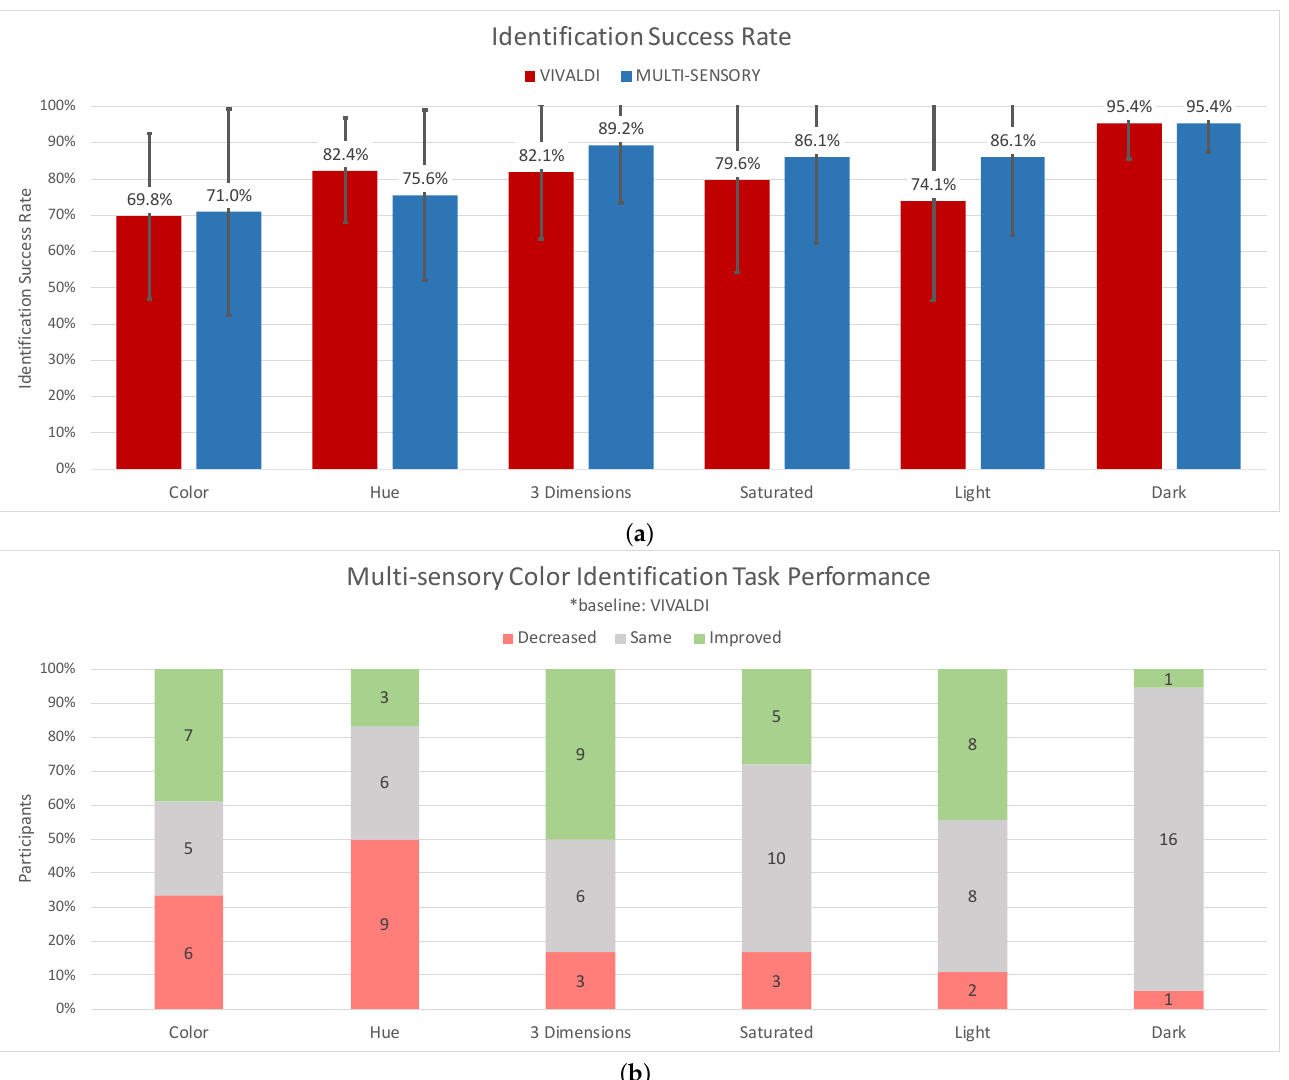
Figure 3. ( a ) Success rate for the different color and color dimensions identification tasks during the VIVALDI and multi- sensory color codes evaluation. ( b ) Comparison of the participants performance achieved during the evaluation of the VIVALDI and multi-sensory color